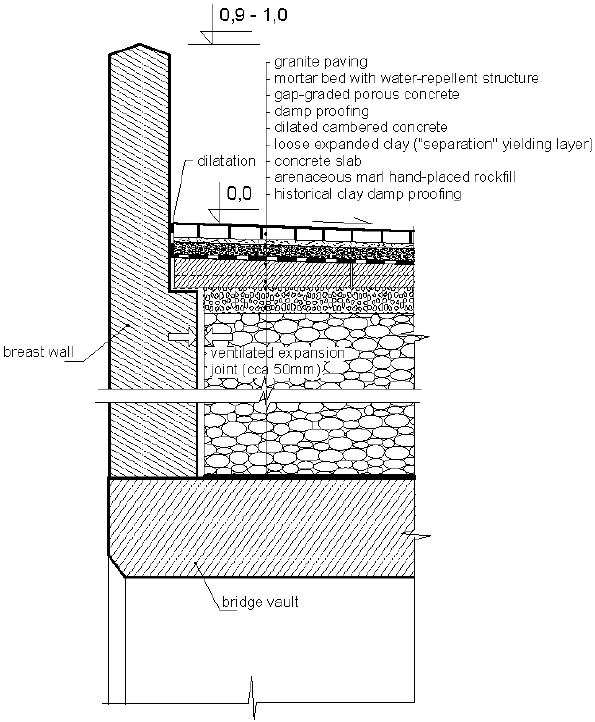
Fig 19. Concept of reconstruction of stone bridge